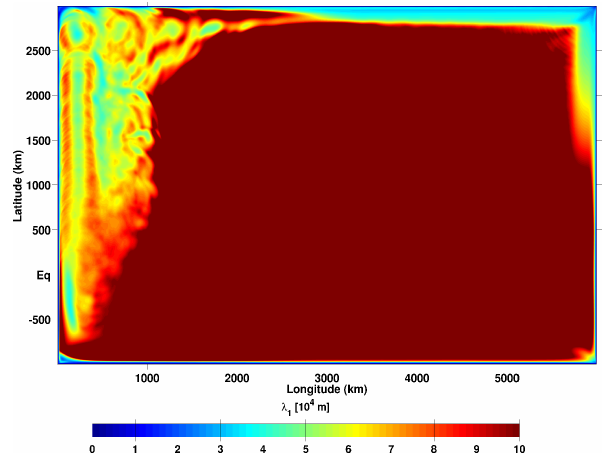
Figure 3. Taylor scale λ 1 (Eq. 11) for the lowest viscosity experi- ment EXP300. Note that the color bar stops at 100km to emphasize the behavior in the extended boundary layer (region of λ 1 ∼